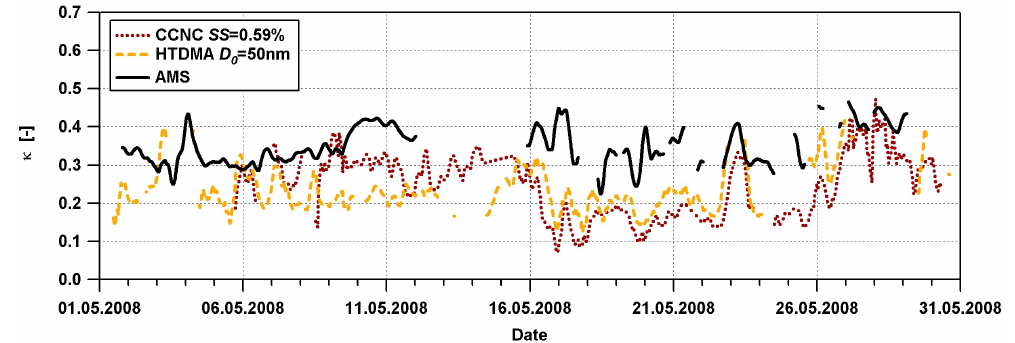
Fig. 9. Time series of hygroscopicity parameter κ derived from the different instruments.